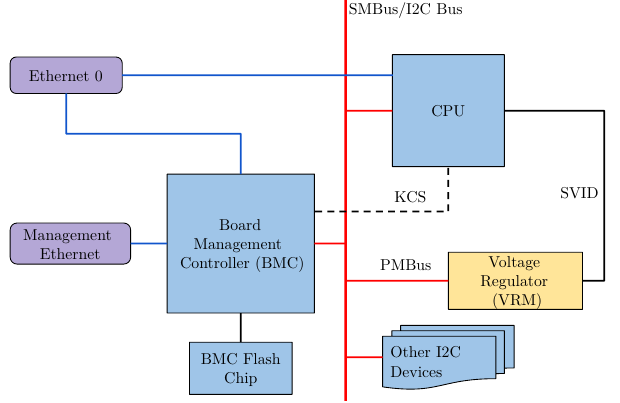
Figure 1: Overview of the connections on the server